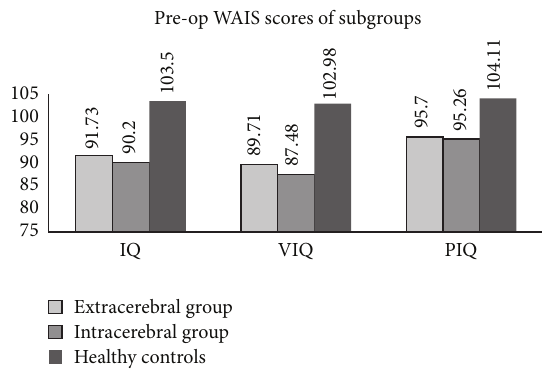
Figure 1: Preoperative IQ, VIQ, and PIQ of both the intracerebral and the extracerebral subgroups were lower than those of the healthy controls ( 𝑃 < .05 ). However, no significant difference was demonstrated between these two tumor subgroups.